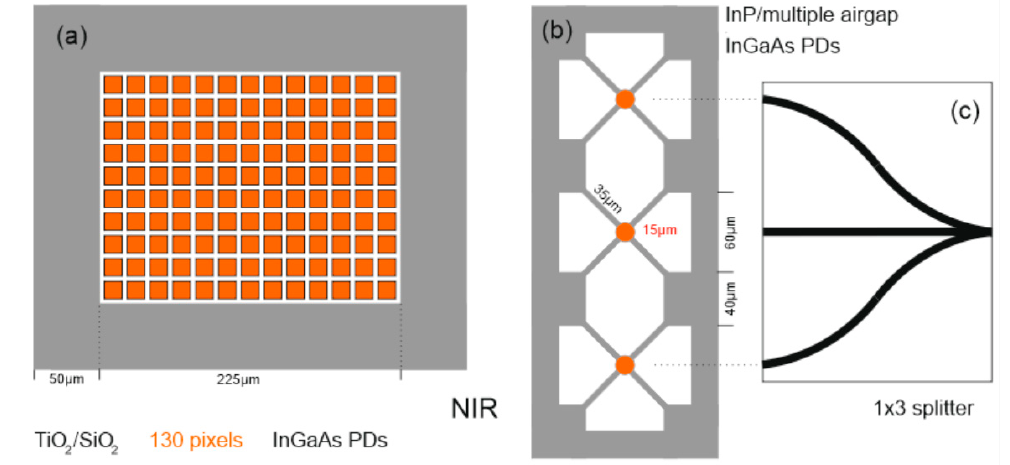
Figure 27. Space requirement to cover 500 nm in the NIR spectral range using tailored InGaAs PDs, not yet available on the market. ( a ) Static FP filter array with a single TiO 2 /SiO 2 DBR. ( b ) MEMS tuneable FP filters in the InP multiple airgap system. ( c ) 1 × 3 splitter, schematically aligned to the 3 tuneable FP